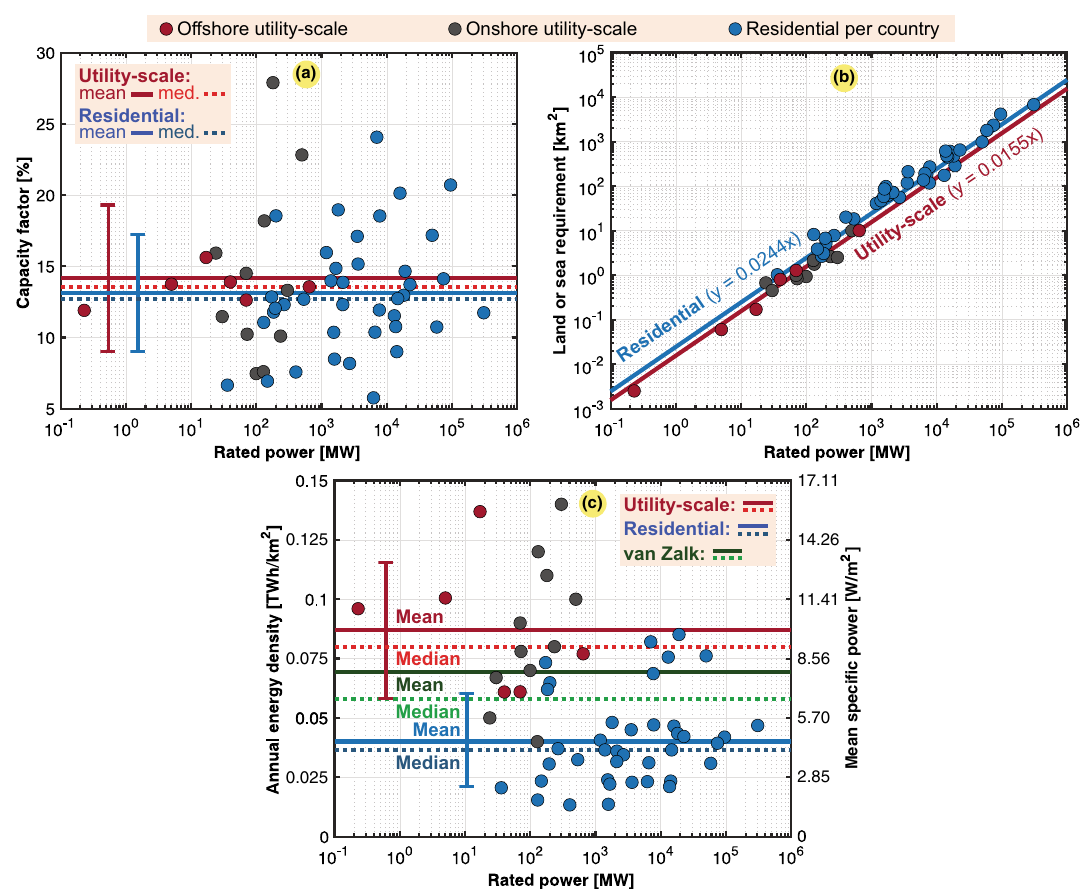
Figure 9. Scatter plots of onshore and offshore utility-scale PV farms and residential PV farms, namely, 11 onshore PV farms ( n = 11 ), including 1 in Peru, 1 in South Korea, 1 in Japan, 1 in Taiwan, 1 in the Philippines, 1 in the Netherlands, 1 in Belgium, 1 in the UK, 1 in Germany, 1 in France, and 1 in Spain, and 6 offshore PV farms ( n = 6 ), including 2 in France, 1 in China, 1 in India, 1 in Japan, and 1 in Singapore. Cumulative residential PV installations in 39 countries ( n = 39 ), including 23 in Europe, 7 in Asia Pacific, 2 in the Middle East, 2 in Latin America, 2 in North America, and 1 in the CIS. Cumulative data retrieved from estimations 5 . Typical, mean, median, and fitted values are also included. ( a ) Capacity factor ( C g ). ( b ) Land use ( A g ). ( c ) Annual energy density ( ε g ) or mean specific power ( p g ) with van Zalk and Behrens 3 as a